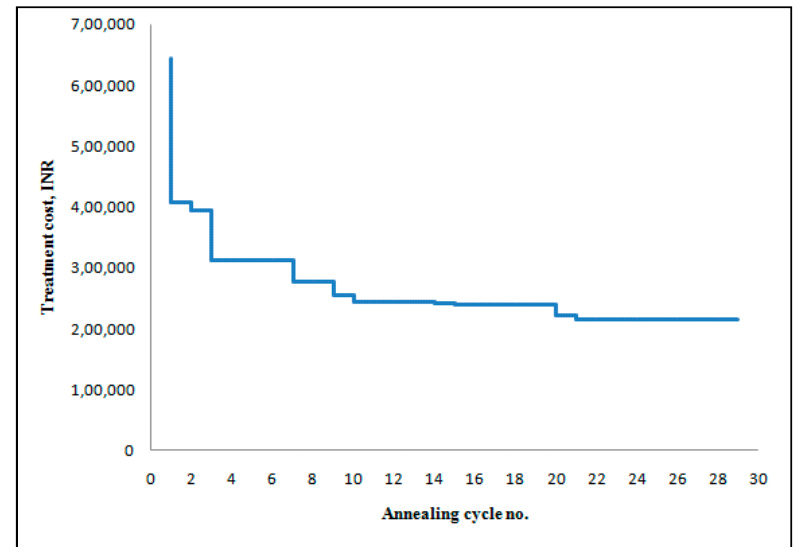
Figure 4. The typical evolution of objective function during the optimisation solution.